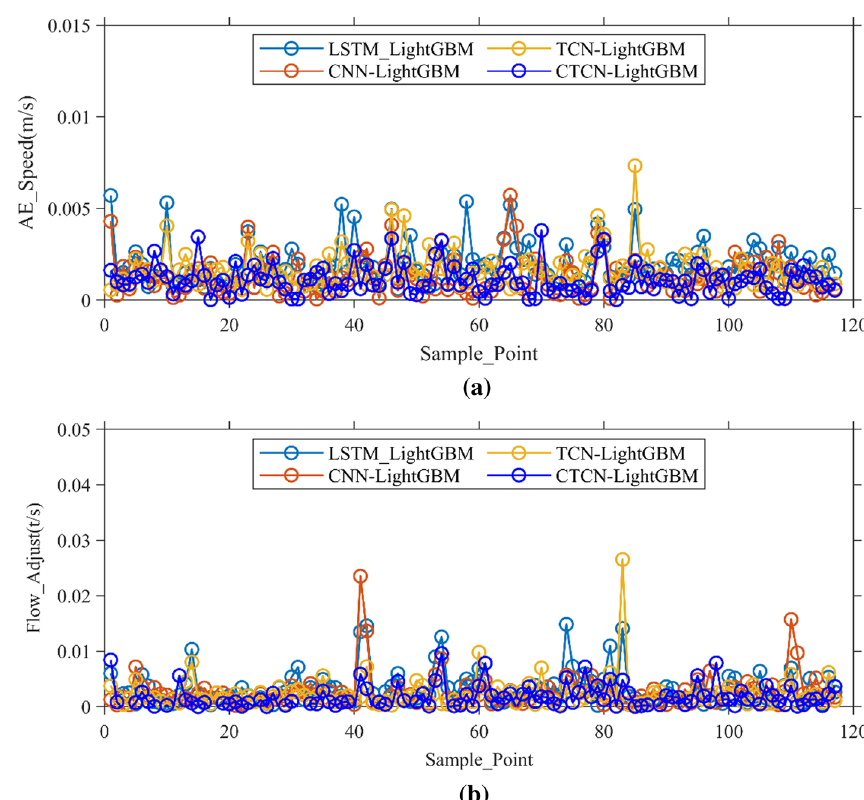
Fig. 11 a Absolute error values of actual prediction results for truck speed adjustment. b Absolute error values of actual prediction results for chute flow